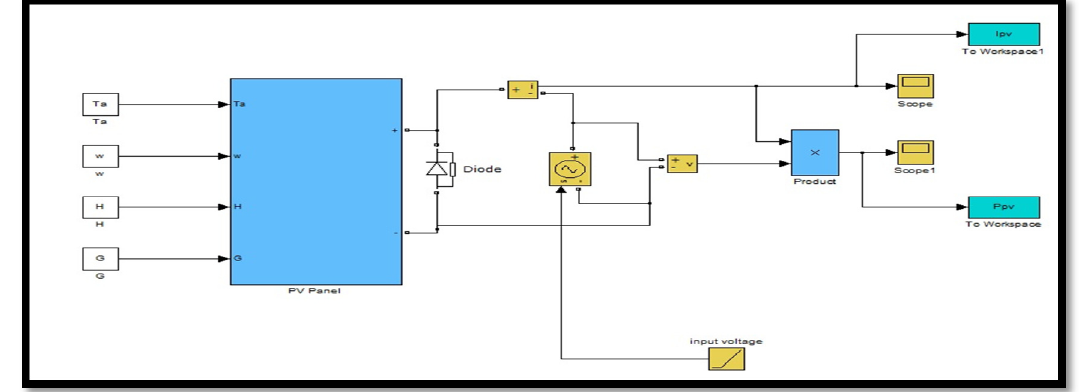
Fig. 2. Simulink model of weather factors effect on performance of PV solar cell.